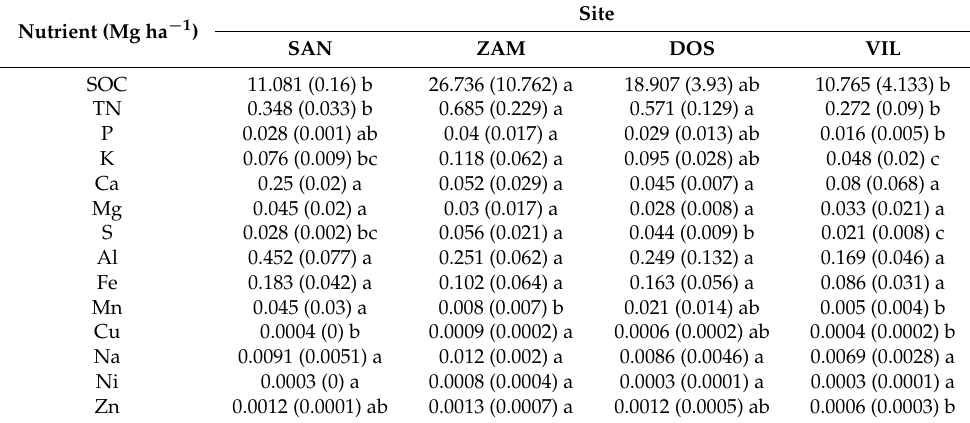
Medians and median absolute deviations MAD in parenthesis. Within each row, different letters indicate significant differences (Benjamini and Hochberg pairwise procedure (HB) after Kruskal-Wallis test, p < 0.05). nDOS = 6; nSAN = 3; nVIL = 7; nZAM = 7.